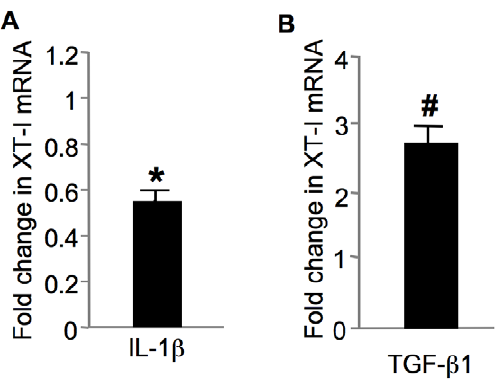
Figure 8. Effect of IL-1 b (A) and TGF- b 1 (B) on XT-I gene expression in normal articular cartilage. Cartilage samples isolated from normal regions of human femoral condyle was exposed to IL-1 b or TGF- b 1 and then XT-I gene expression was analyzed by qPCR. Measurements were normalized to control (non treated). Each value represents the mean 6 SD of 3 experiments per parameter per joint per patient. *Significantly ( P , 0.05) lower than control group; # significantly ( P , 0.01) higher than control